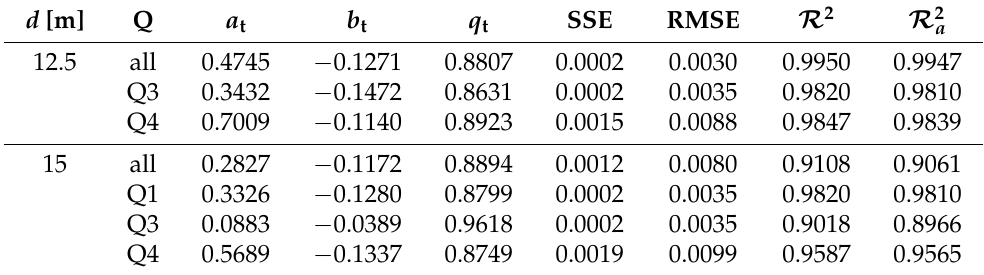
Table 4. Coefficients of the models for long freeze lengths x ∈ X t in the tails.